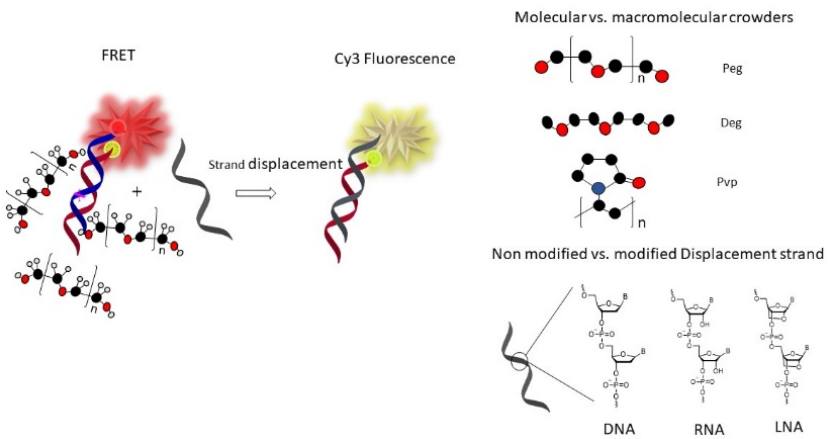
Figure 1. The key principle of the Föster resonance energy transfer (FRET) assay used in this study to investigate strand exchange. Initially, the duplex (ds) is labeled with a FRET pair of the fluorescent dyes Cyanine 3 (Cy3) and Cyanine 5 (Cy5). FRET occurs because of the close contact between the donor (Cy3) and the acceptor (Cy5) dyes. In particular, energy is transferred from the Cy3 to the Cy5 fluorophore through dipole-dipole interactions. As a result, the fluorescence emission from Cy5 is maximal. The addition of various (DNA, RNA, DNA-LNA) single displacement strands (DS) in different buffer conditions leads to the formation of a new duplex causing dissociation of the original duplex, resulting in a decreased FRET and decreased Cy5 fluorescence emission. These events were monitored over time to quantify the kinetics of strand exchange. Peg is polyethylene glycol, deg is diethylene glycol dimethyl ether, pvp is polyvinylpyrrolidone, and LNA is locked nucleic